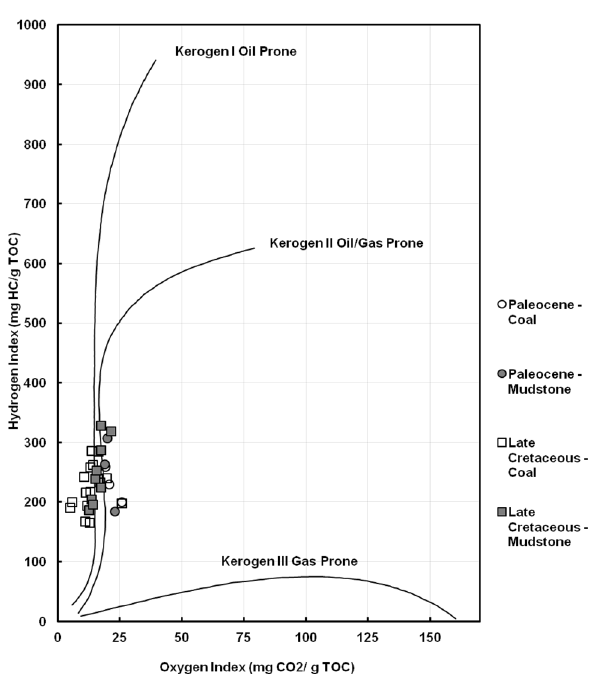
Fig. 6 A cross-plot of hydrogen index (HI) versus oxygen index (OI) in the modified Van Krevelen diagram shows the type of kerogen available in the Taratu source rock (Espitalié et al.